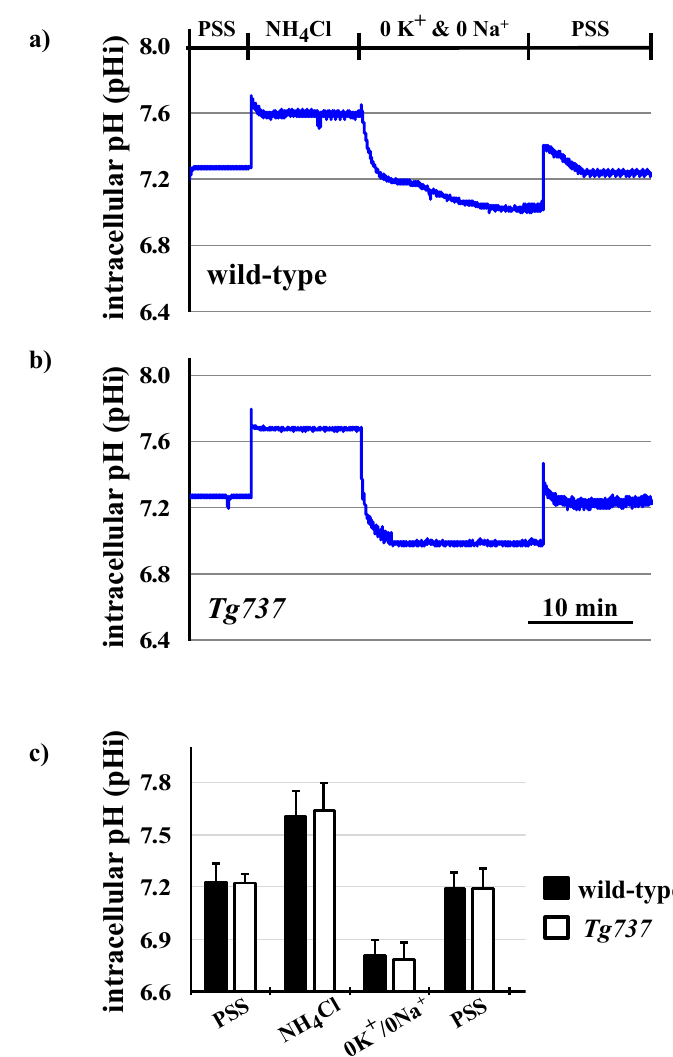
Figure 5. Changes in pH i during the NH 4 Cl pre-pulse in wild-type and Tg737 cells. ( a,b ) Representative tracings of changes in intracellular pH when wild-type and Tg737 cells are exposed to solutions of the NH 4 Cl pre-pulse in Na + - and K + -devoid solution for pH i recovery. ( c ) Bar graph shows the summary of mean changes in pH i recovery in wild-type and Tg737 cells. N = 5 for wild-type cells and N = 3 for Tg737 cells.